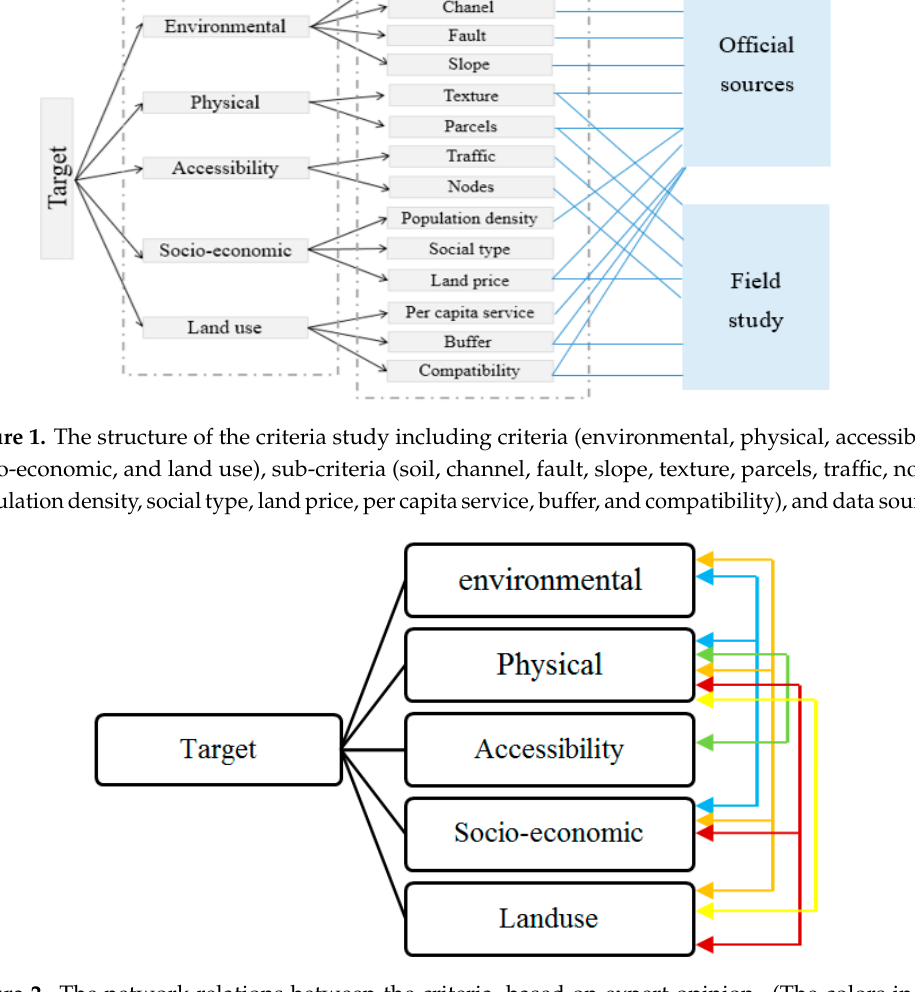
Figure 2. The network relations between the criteria, based on expert opinion. (The colors in this figure are simply due to the better readability of the relationships between the criteria and have no special meaning) .